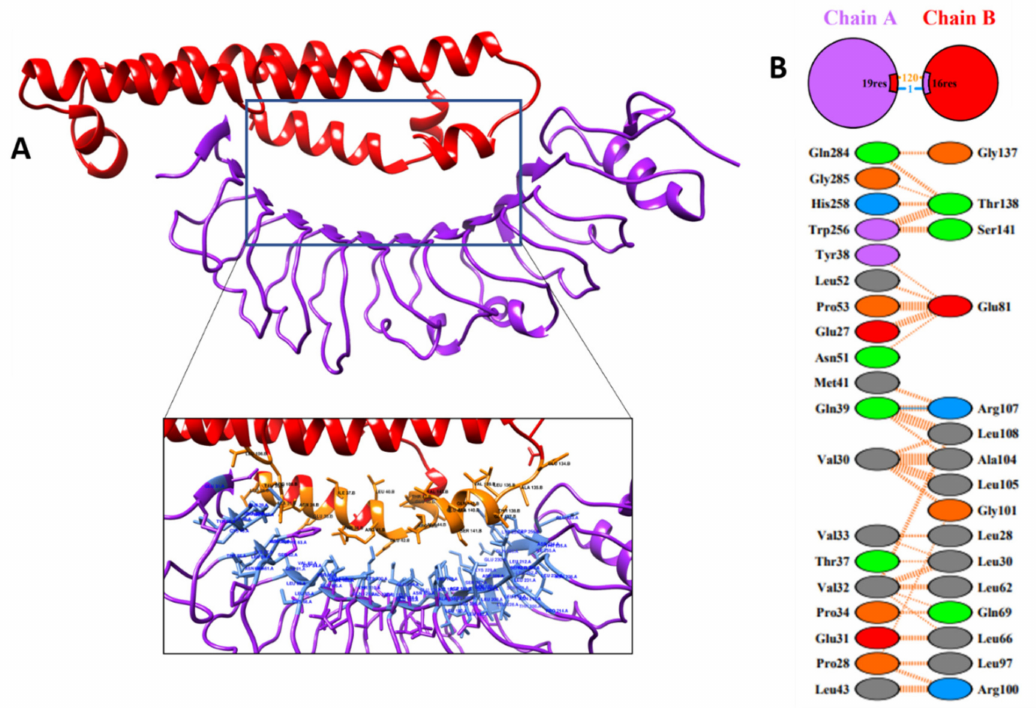
Figure 4. Docked vaccine construct with TLR4/MD. ( A ) Docked complex of vaccine construct (red) and TL4/MD (purple). ( B ) Non-bonded interactions between the vaccine model and TLR4/MD protein shown in orange. Blue line represents hydrogen bond between the docked